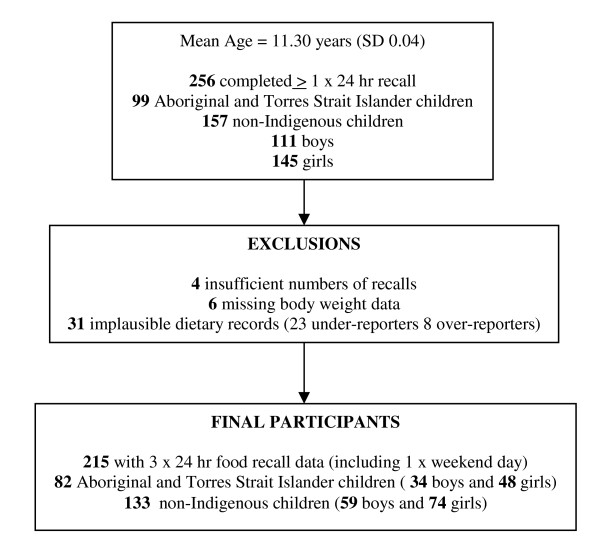
Study Population.